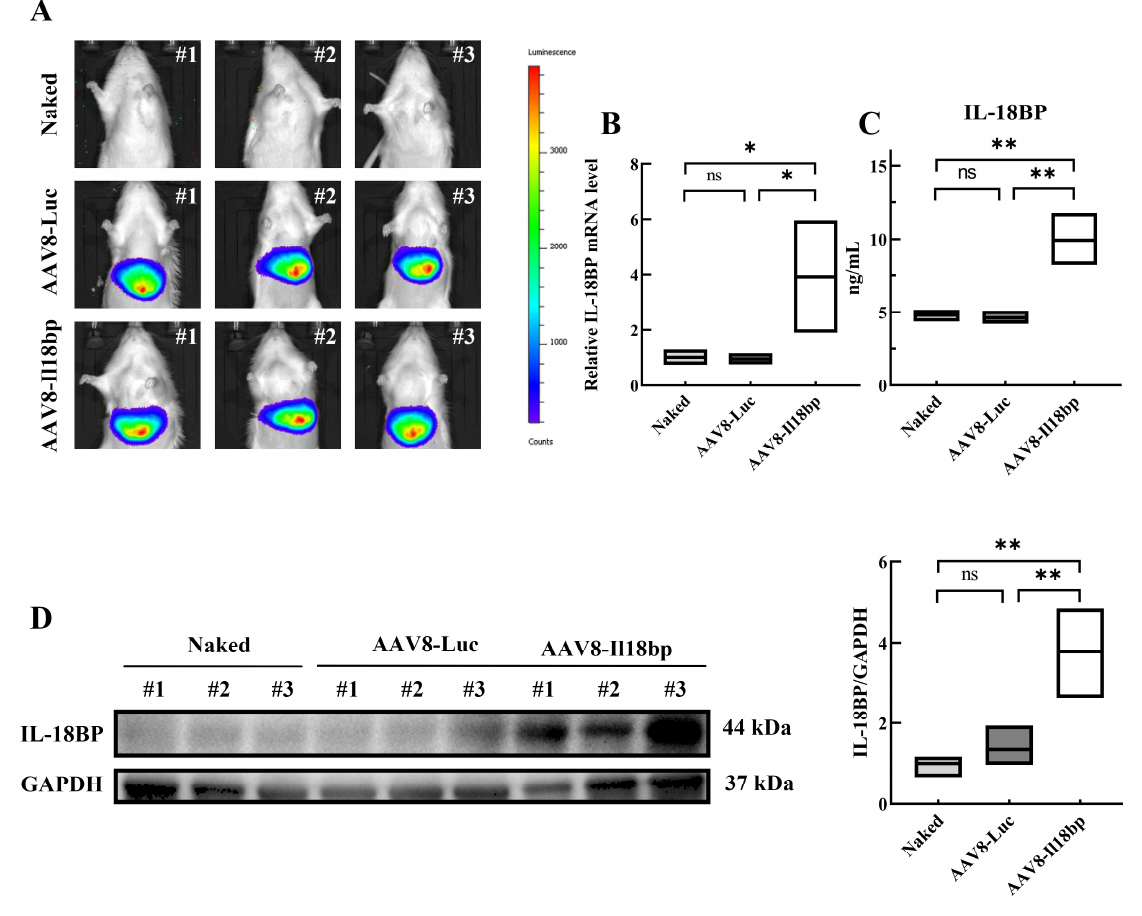
Figure 1. Specific overexpression of IL-18BP in the liver of LEW rats treated with AAV8-Il18bp. ( A ) Live imaging of animals showed that the livers of LEW rats administered with AAV8-Luc and AAV8-Il18bp emitted significant bioluminescence after intraperitoneal injection of fluorescein potassium salt; however, naked LEW rats did not emit bioluminescence. ( B ) The mRNA levels of IL-18BP were significantly increased in the liver tissue of LEW rats given AAV8-Il18bp compared with LEW rats given AAV8-Luc or untreated. ( C ) ELISA showed serum IL-18BP levels were higher in the AAV8-Il18bp group than in either of the other two groups. ( D ) Western blotting results showed that the livers of LEW rats administered with AAV8-Il18bp could significantly express IL-18BP compared with the other groups. Results represent the mean ± SEM ( n = 3 per group); * p < 0.05; ** p <